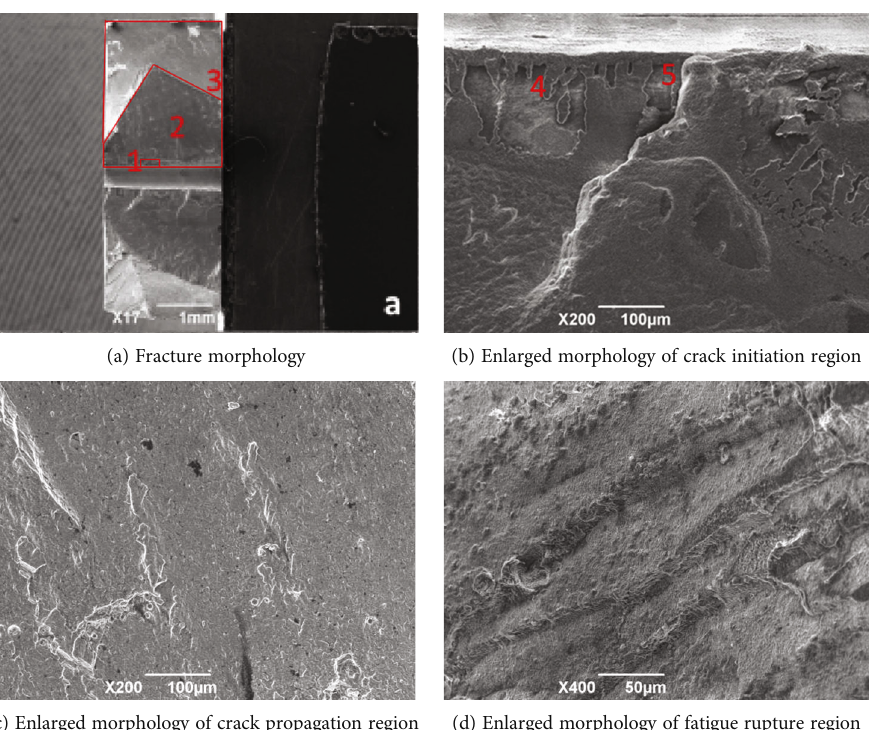
Figure 10: Fracture morphology of single-hole